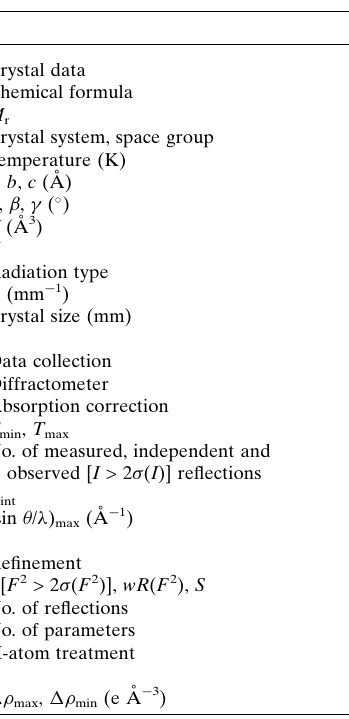
Table 2 Experimental details.